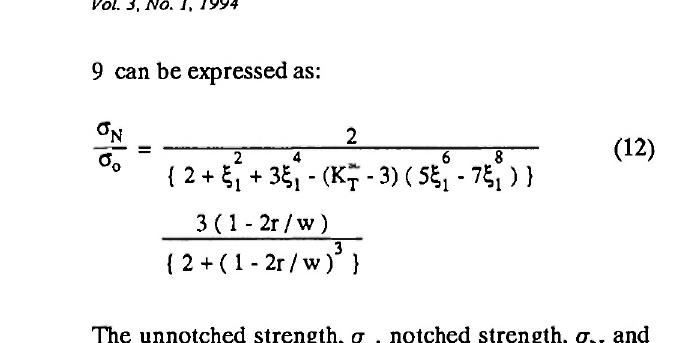
Stress concentration factor (Kp 00 ) and strength ratio were calculated from the experimental data.